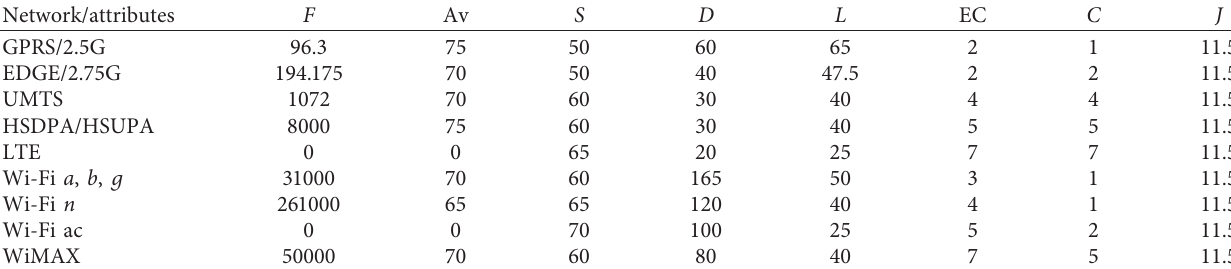
Table 5: An example of a decision matrix in a defined decision point from the dataset. Network/attributes